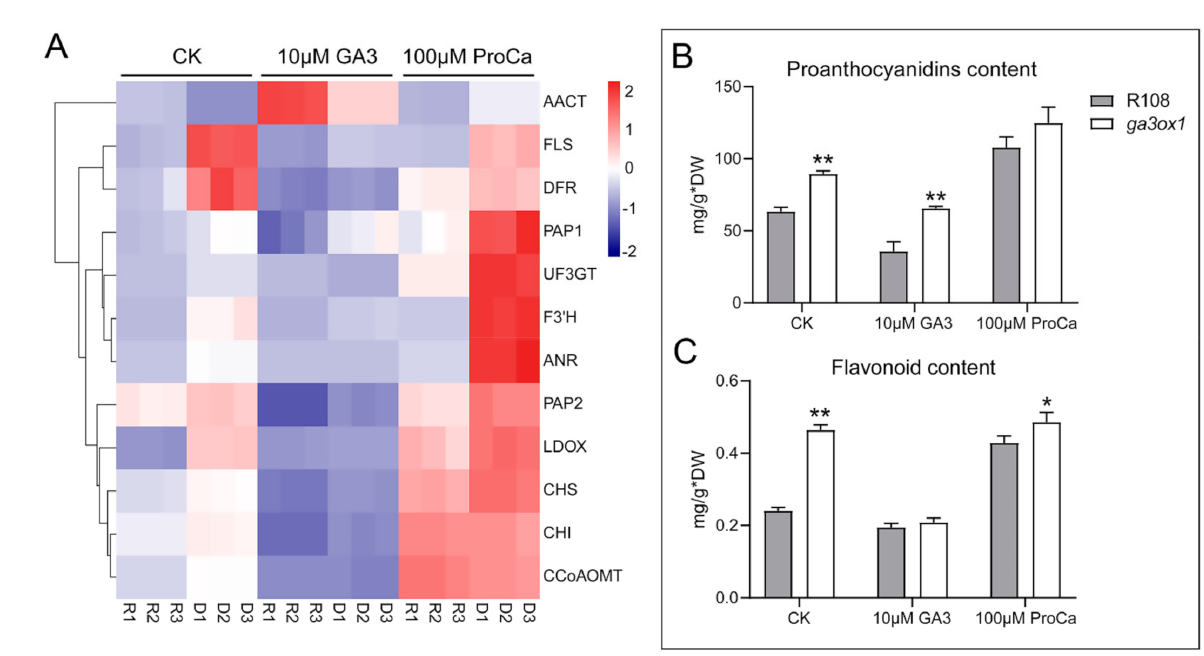
Figure 6. Treatment with exogenous GA 3 inhibited flavonoid and isoflavonoid biosynthesis pathways, while treatment with prohexadione calcium promoted these processes. ( A ) Transcriptional abundance of flavonoid biosynthesis genes after treatment with exogenous GA 3 and prohexadione calcium. The heatmap was built using the OmicShare tools, a free online platform for data analysis (http://www.omicshare.com/tools, 9 May 2020). According to the color scale on the right of the Figure, each colorized cell represents the averaged spot quantity, and the color scale indicates fold change of the mRNA expression levels. ( B , C ) Flavonoid content and proanthocyanin content of wild-type R108 and ga3ox1 mutant leaves were determined by spectrophotometer. Three biological replicates were analyzed, and error bars denote the SD. DW: dry weight. * p < 0.05, and ** p < 0.01 by Duncan